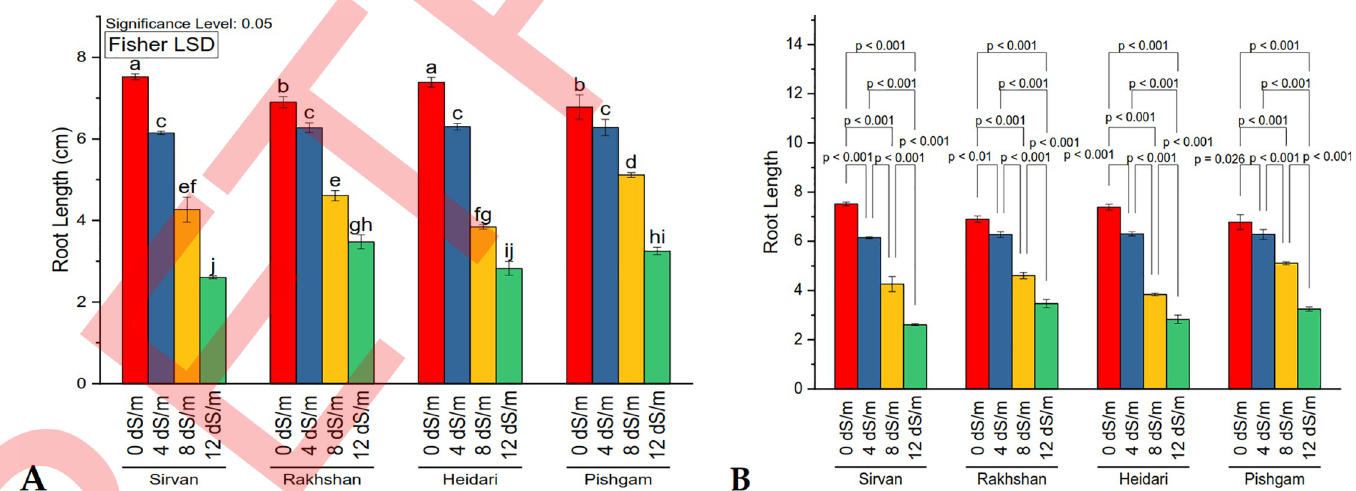
PLOS ONE | https://doi.org/10.1371/journal.pone.0258703 November4,